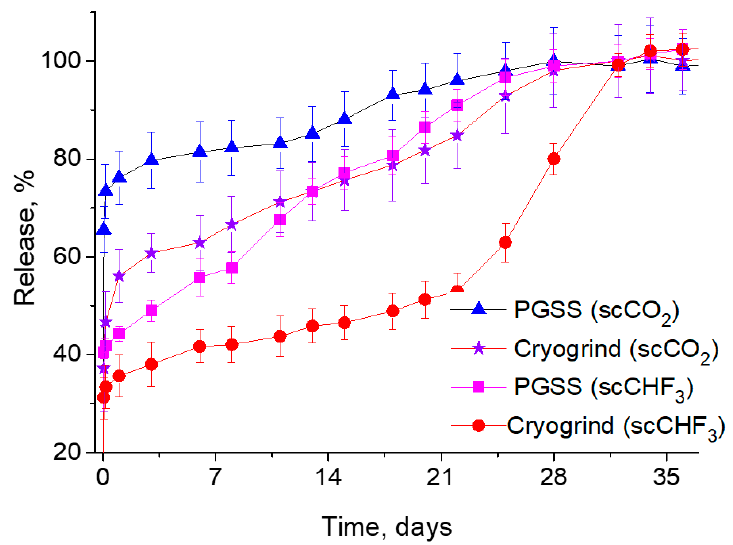
Figure 7. Kinetics of LFX release from polymer microparticles produced by the PGSS technique and the cryogrinding of PLGA scaffolds fabricated using scCO 2 and scCHF 3 .